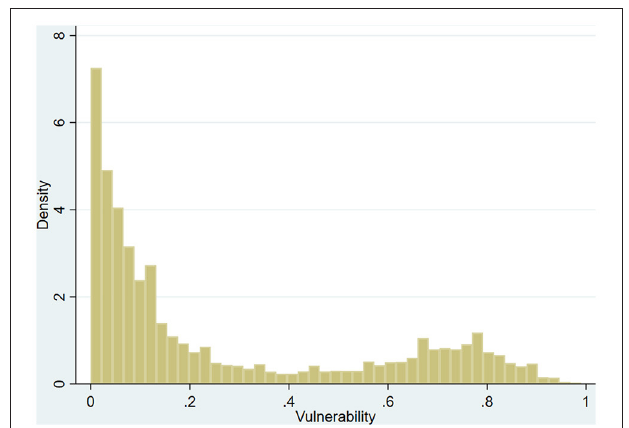
FIGURE 1 | Histogram of vulnerability to